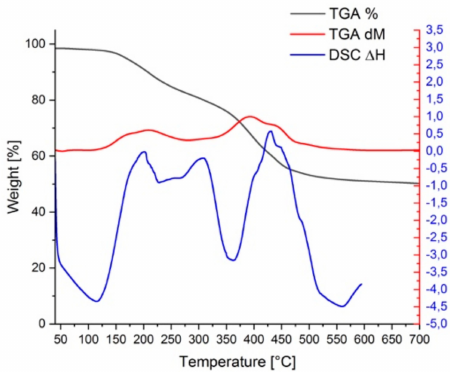
Figure 1. Thermogravimetric analysis (TGA) and di ff erential scanning calorimetry (DSC) thermograms under nitrogen of the photo crosslinked CPZ